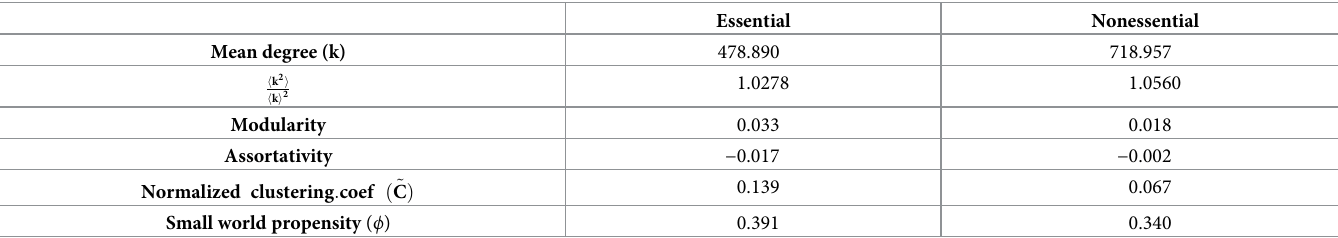
Fig 2. The radar plot shows six standard network’s indicators in both essential and nonessential gene networks. Mean degree, the ratio between mean of squared degrees and squared of mean degree, modularity, assortativity coefficient, normalized clustering coefficient, and small-world propensity. The radar plot for the essential gene network is plotted in blue and for the nonessential gene network in yellow. https://doi.org/10.1371/journal.pone.0258596.g002 networks, the ratio between mean squared degrees and squared of mean degree is close to one. This implies that neither nodes with high degrees nor those with a medium degree are signifi- cantly dominant over the other one. In addition, the value of the modularity in the essential net- work is more than that of in the nonessential network. The higher value of this indicator in the essential gene network than the nonessential one indicates the higher tendency to be clustered into multiple sets of strongly interacting parts. Moreover, as it has been illustrated in Table 1, the assortativity coefficient in both networks is negative but so close to zero, i.e., both networks show weak disassortative behavior. However, the magnitude of disassortativity is one order Table 1. Network’s